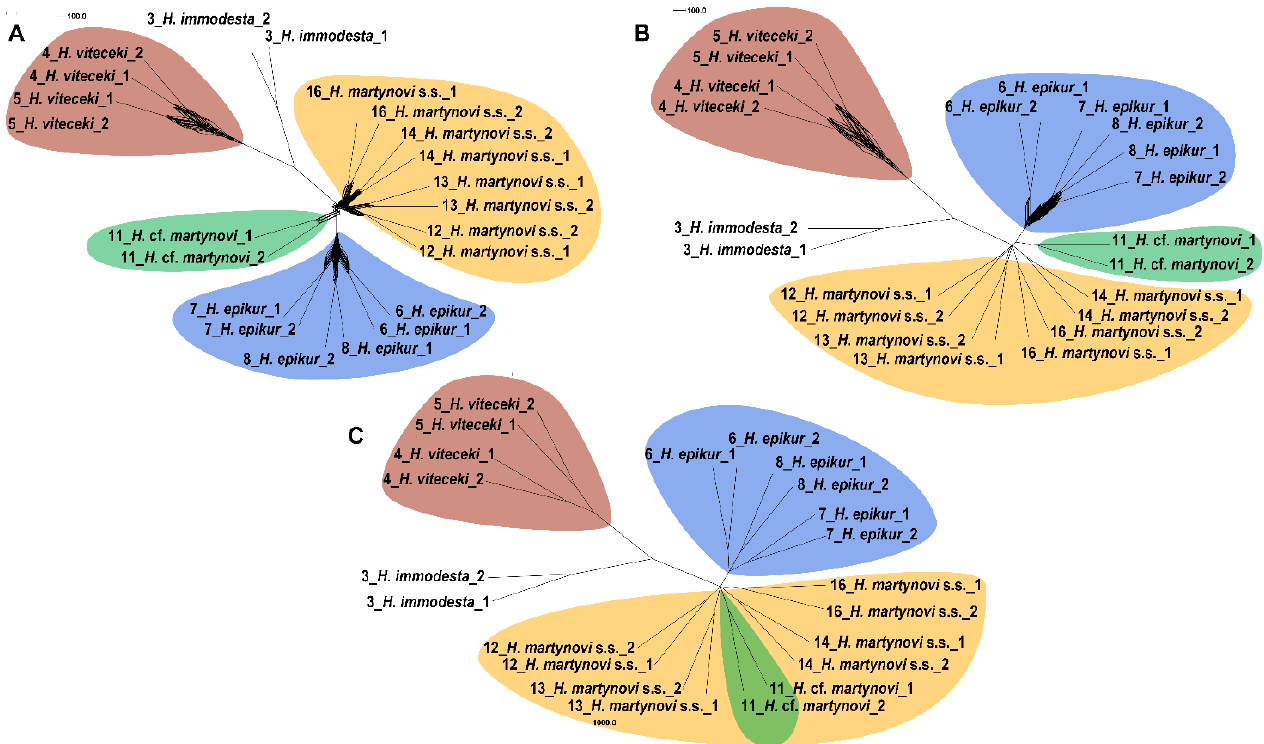
Figure 3. Network of Himalopsyche martynovi complex based on all the RaxML gene tree using SplitsTree. The thresholds were set to 3% ( A ), 5% ( B ) and 20% ( C ), respectively. H. martynovi s.s. is the abbreviation of H. martynovi sensu stricto.